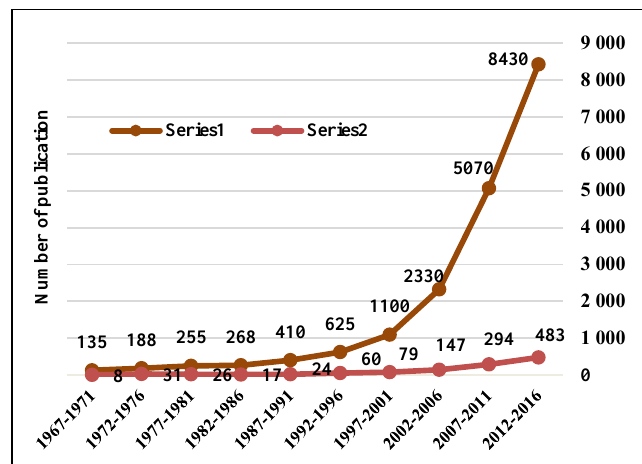
Figure 1: Number of publications related to ”giant reed” or ”Arundo donax” in Google Scholar’s database (between